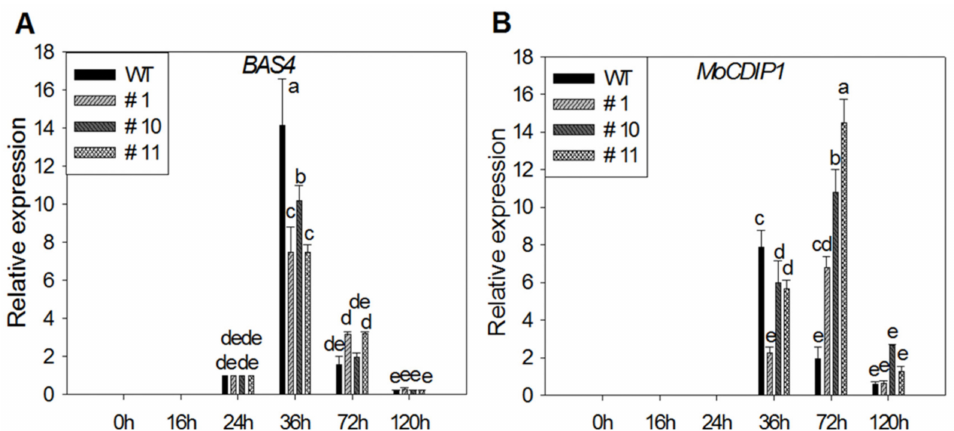
Figure 6. Expression of pathogenesis-related genes of Magnaporthe oryzae in WT and three MoSDT1 transgenic lines. ( A , B ) Relative expression levels of MoBAS4 and MoCDIP1 . Di ff erent letters represent statistically significant di ff erences ( p <